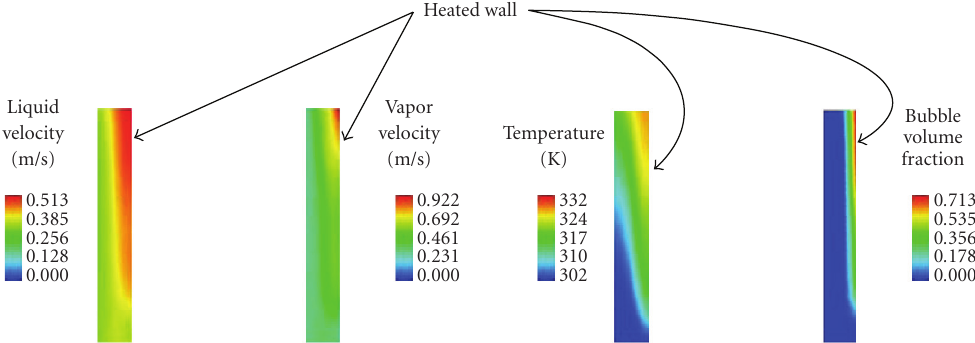
Figure 5: Color contours of the calculated phasic velocities, temperature, and void fraction in subcooled boiling: mass flux = 512 kg / m 2 s, heat flux = 241 kW / m 2 , inlet subcooling = 30K.